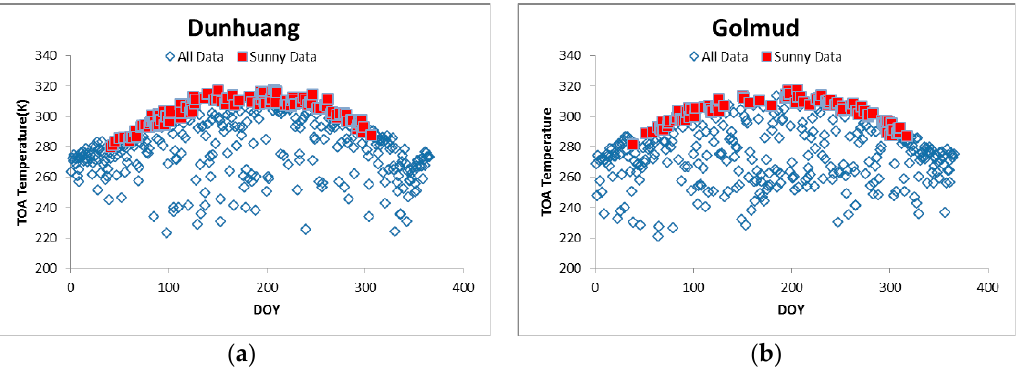
Figure 5. Top-of-atmosphere (TOA) bright temperature (BT) of all images (blue hollow rhombus) and images of sunny days with difference less than 10 K between TOA BT and envelope brightness temperature (EBT) (red solid frame): ( a ) Dunhuang; ( b ) Golmud.